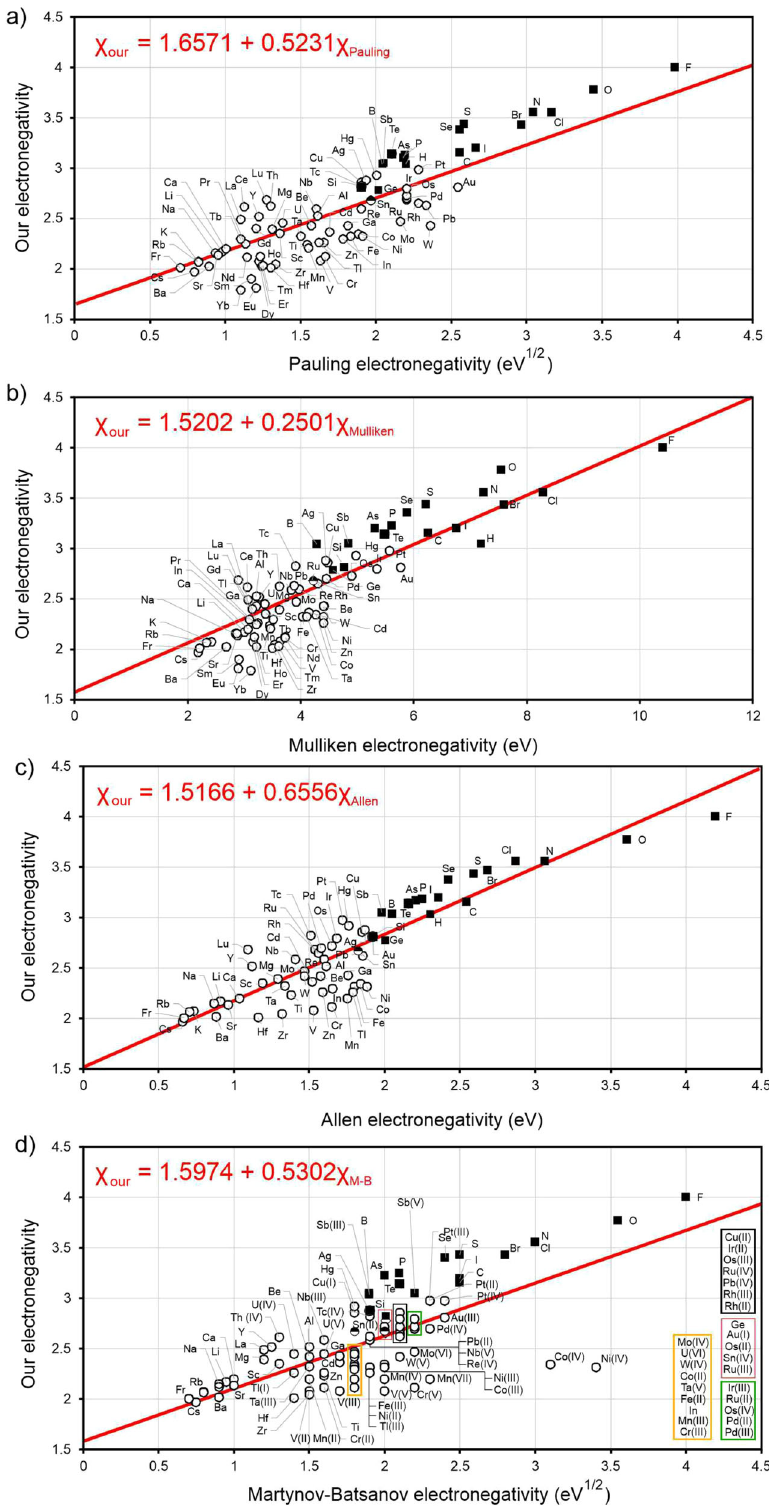
Fig. 2 The correlation between our thermochemical electronegativities ( X our ) on y -axis (dimensionless) with others electronegativities ( x -axis). (a) X our vs Pauling (in eV 1/2 ), ( b ) X our vs Mulliken (in eV), ( c ) X our vs Allen (in eV), and ( d ) X our vs Martynov-Batsanov (in eV 1/2 ). Lines indicate the linear correlation. Legend: metals, empty circles; non-metals, full